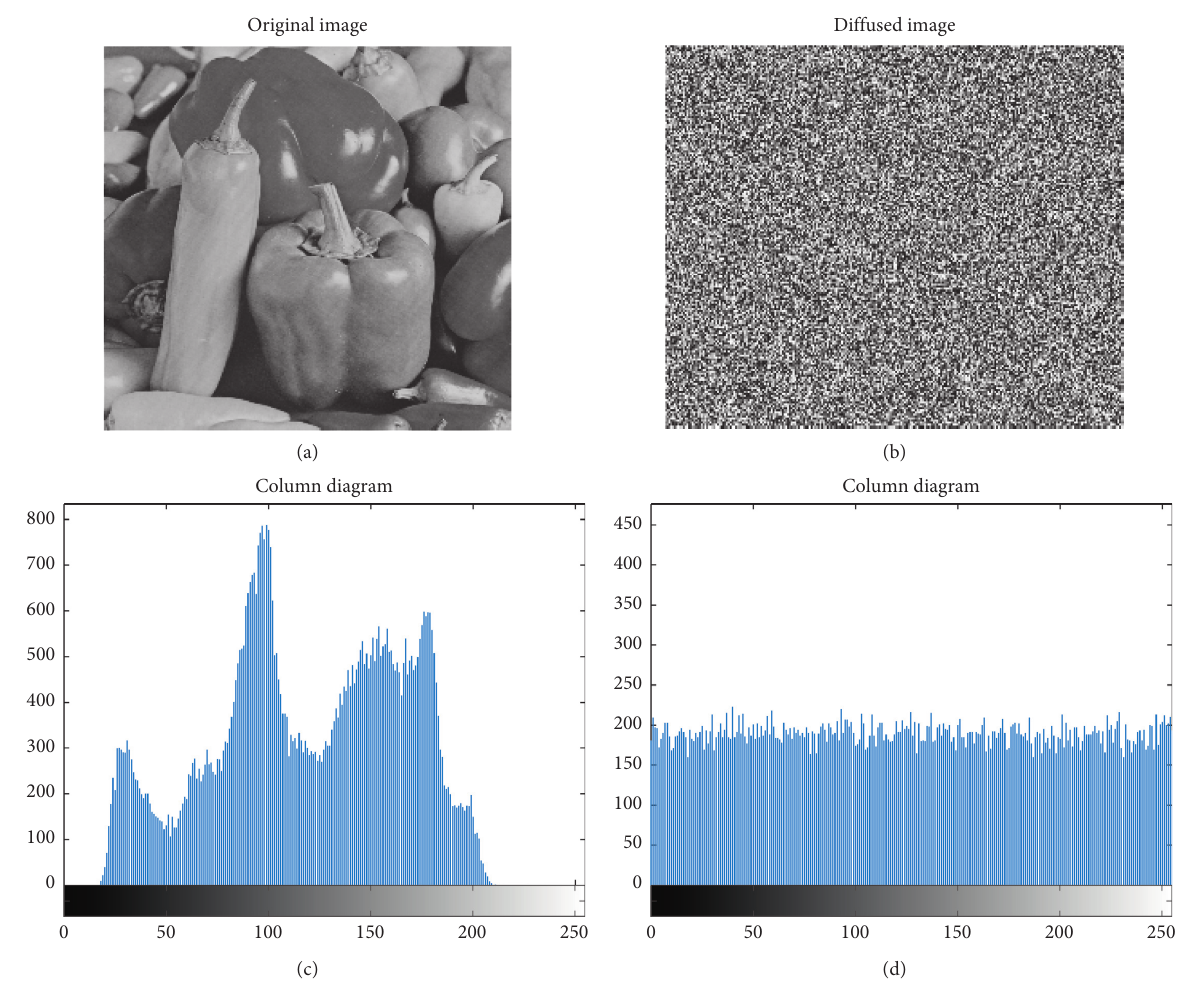
Figure 6: Histogram of original and encryption image: (a) original image, (b) cipher image, (c) histogram of plaintext image, (d) and histogram of cipher text image. Table 2: Information entropy of encrypted